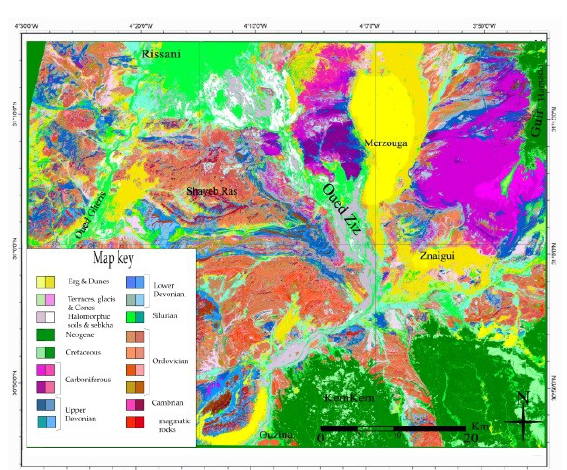
Figure 11: Maximum likelihood classification image